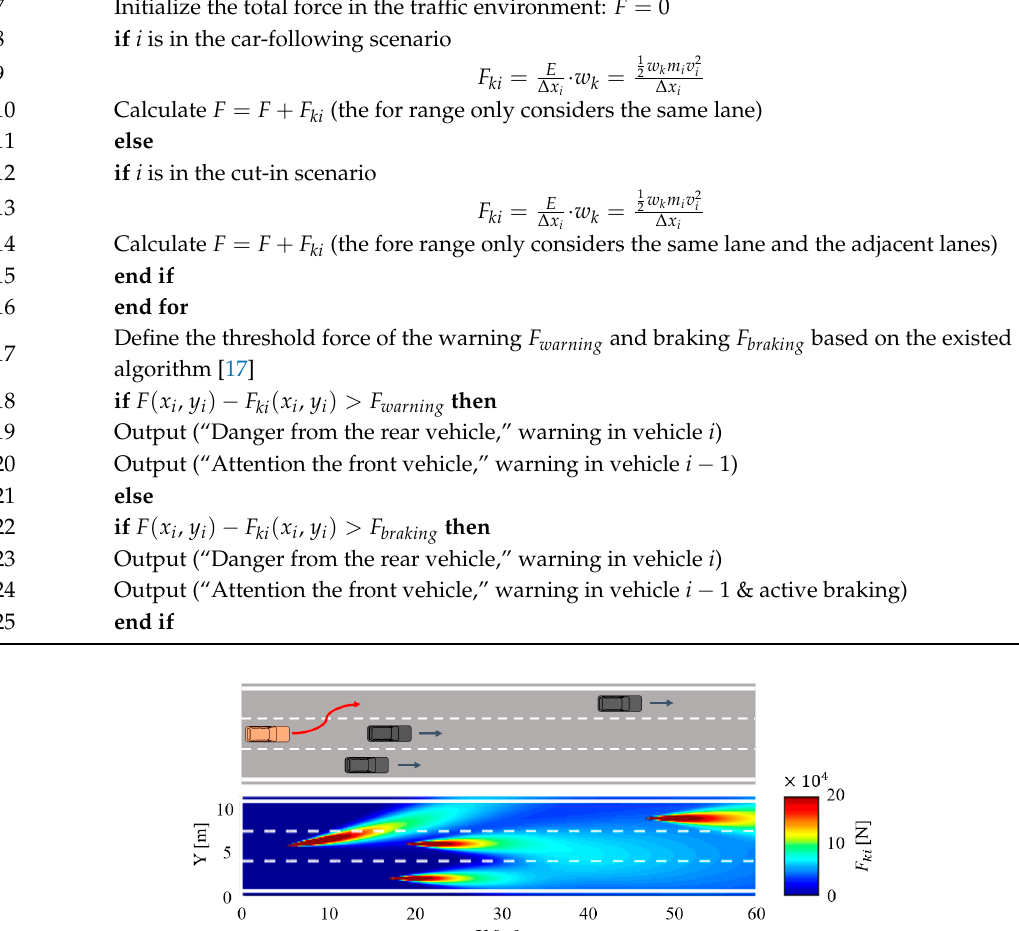
Figure 3. The setting of weights according to the HMM algorithm. It's going to be challenging to solve for 𝑆 (cid:3047) if we set the value of 𝑛 too large. However, to make the calculation of equivalent force more accurate, we need to set the increment of steering angle more closely. So as long as the corresponding steering angle in the corresponding interval is (𝛿 (cid:3038)(cid:2879)(cid:2869) ,𝛿 (cid:3038) ] or [𝛿 (cid:2879)(cid:3038) , 𝛿 (cid:2879)(cid:3038)(cid:2878)(cid:2869) ) , the weight will take 𝑤 (cid:3038) or 𝑤 (cid:2879)(cid:3038) .